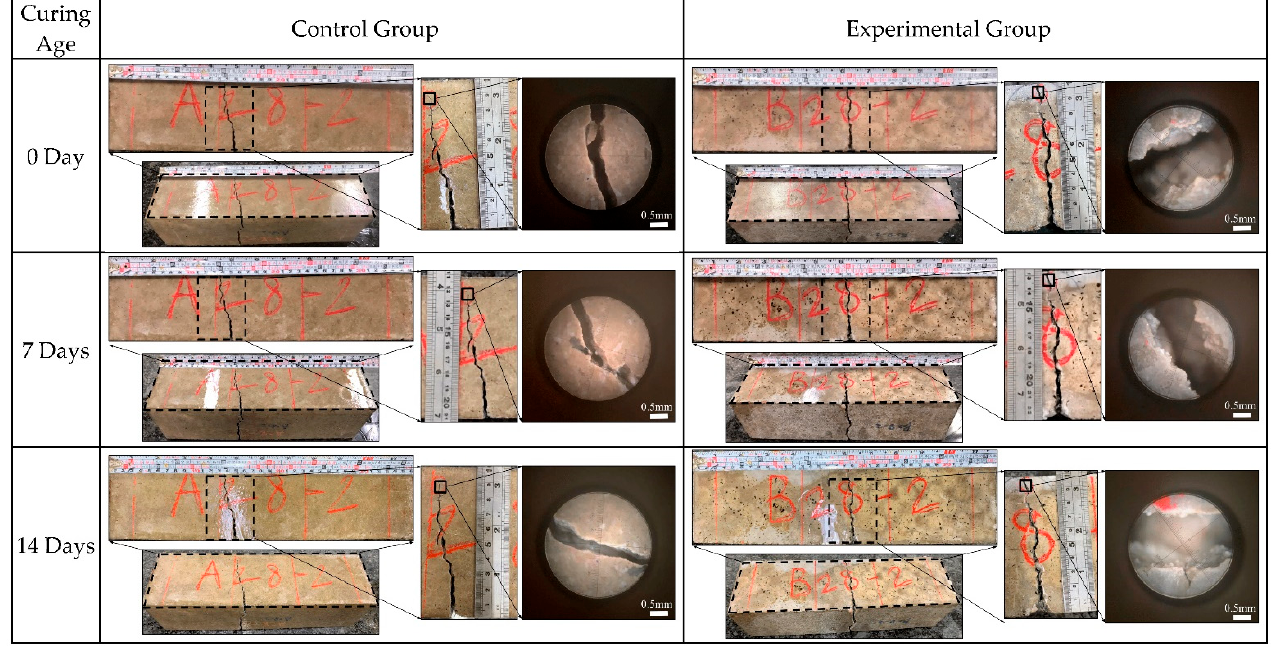
Figure 25. Microscopic images of crack healing of the concrete specimens at different self-healing ages.